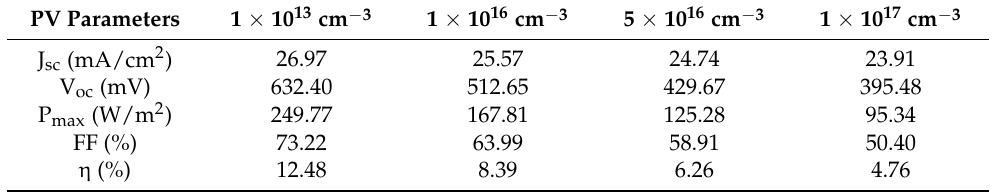
Figure 8. Cell parameters as a dependence of energy level for acceptor trap from 2D simulations for Table 2. PV characteristics with different absorber defect densities at a fixed energy level (0.4 different defect densities.